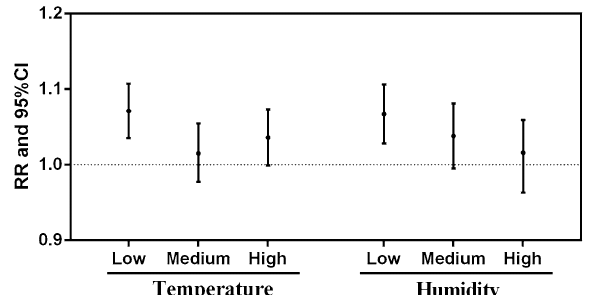
Figure 5. Associations between PM 2.5 and AECOPD cases based on different levels of temperature and